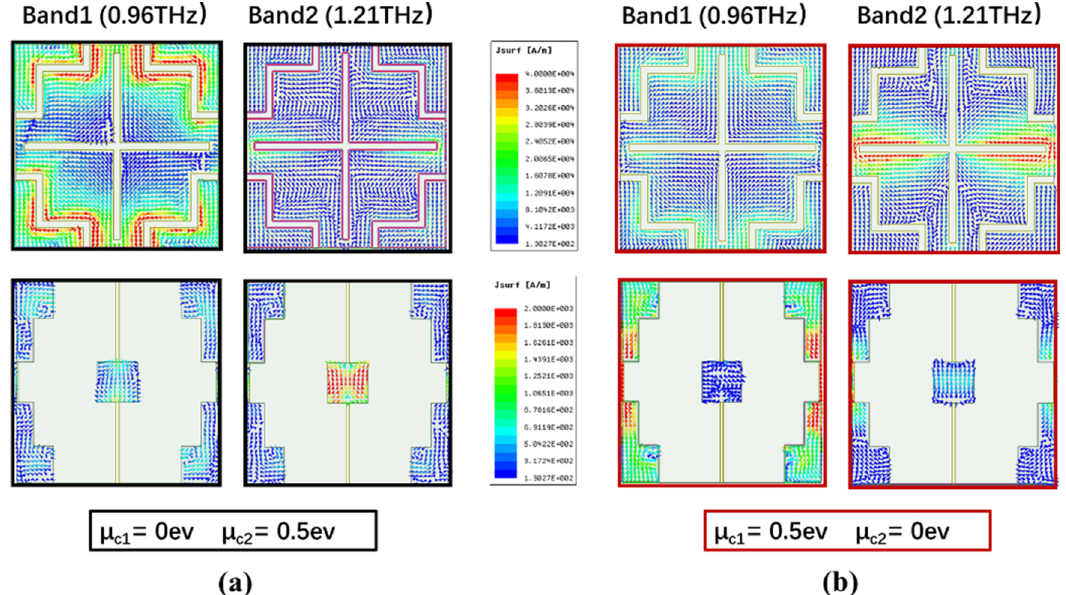
Fig. 2. Surface current distribution of AFSS in different states at frequencies f 1 = 0.96THz and f 2 =1.21 THz,